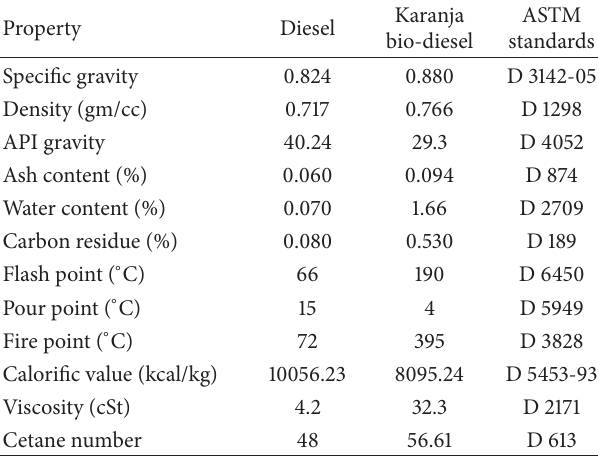
Table 2: Fuel property table of diesel and Karanja oil methyl ester. Property Diesel